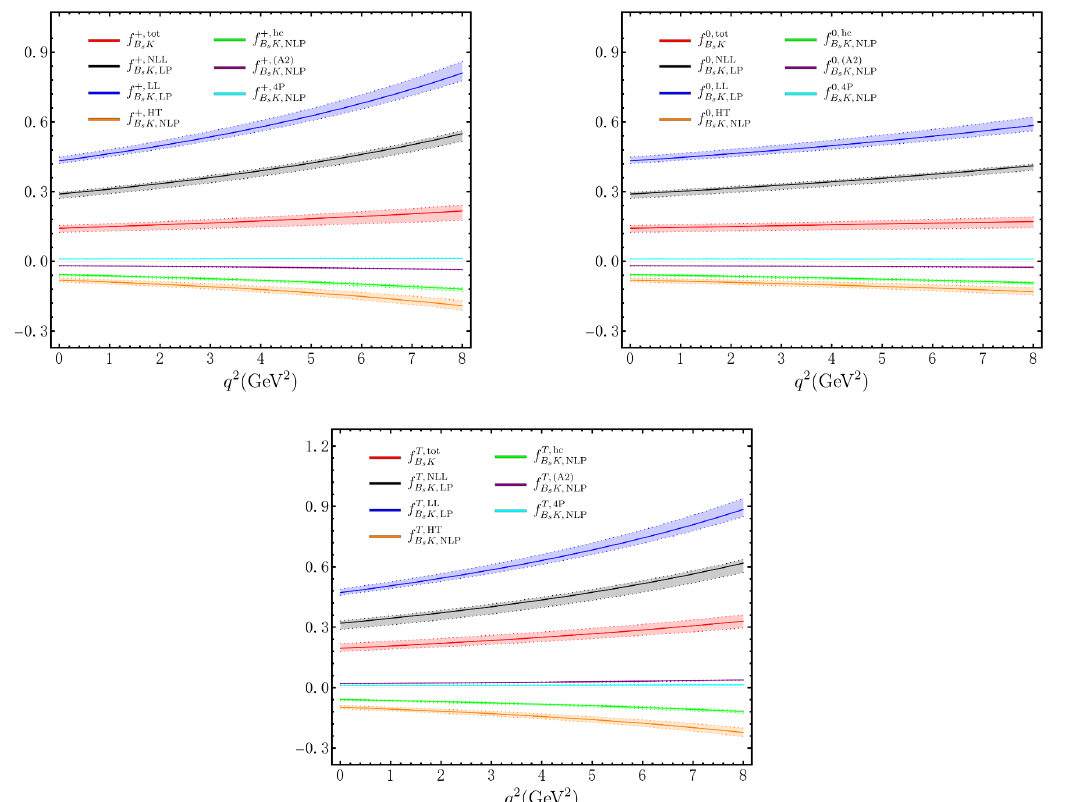
Figure 4 . Breakdown of the distinct dynamical mechanisms contributing to the semileptonic B s → K‘ ¯ ν ‘ form factors in the kinematic region 0 ≤ q 2 ≤ 8 GeV 2 from the updated LCSR computations with the HQET bottom-meson distribution amplitudes, where the perturbative uncertainties due to the variations of both the hard and hard-collinear matching scales are indicated by the individual error